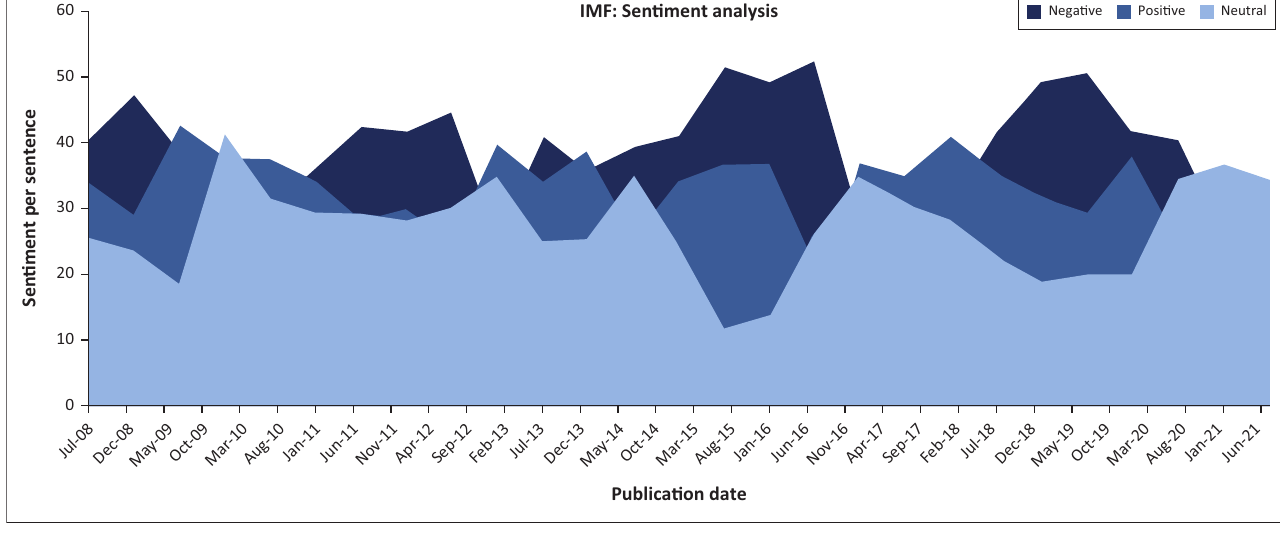
IMF, International Monetary Fund. FIGURE 2: The line plots indicate how the sentiment extracted from the International Monetary Fund global economic outlook changed from 2008 to 2021 by comparing the proportion of positive, negative and neutral